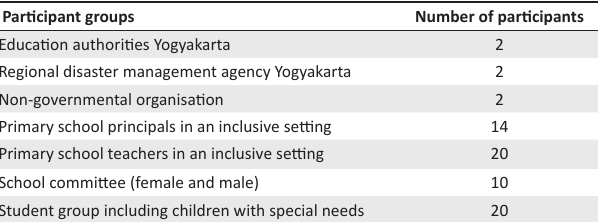
FIGURE 1: Yogyakarta earthquake risk TABLE 1: List of participants.